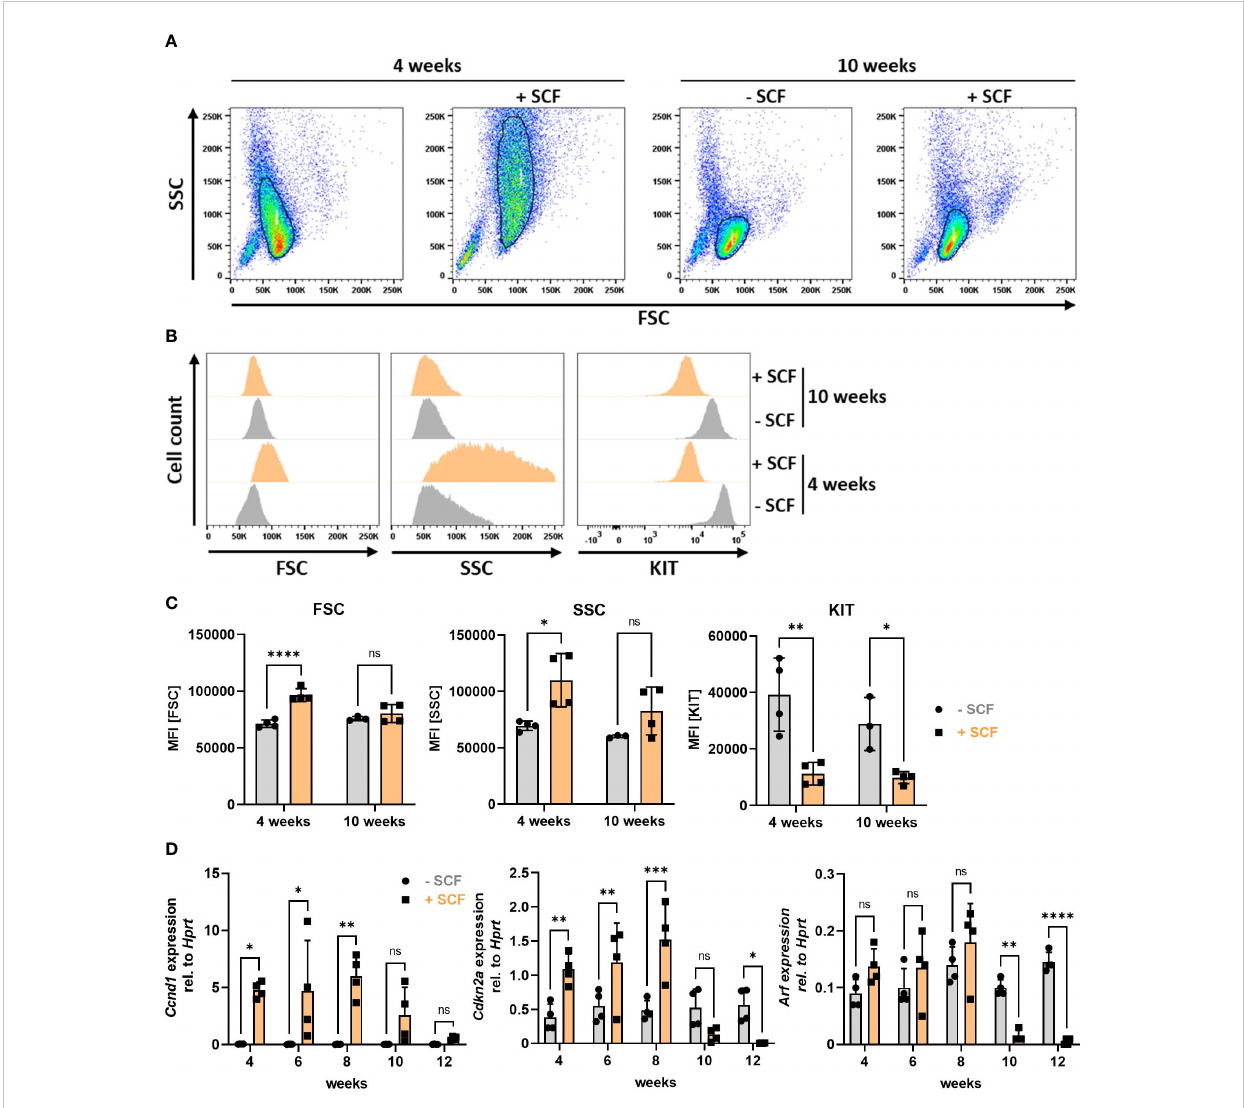
FIGURE 8 Constitutive KIT activation induces morphological changes and loss of Cdkn2a/Arf expression in BMMCs. (A) Representative FACS-plots showing BMMC populations cultivated with or without SCF for 4 (left) or 10 (right) weeks (n=4). (B) Representative histograms showing frequency distributions offorward scatter (left), side scatter (middle) and KIT expression (right) of BMMCs cultivated for 4 or 10 weeks with or without SCF (n=4). (C) Quanti fi ed data (MFI) of parameters analyzed in (B) [n=4 for all data except for BMMCs -SCF at 10 weeks (n=3)]. (D) RT-qPCR analysis of Ccnd1 , Cdkn2a and Arf mRNA expression in BMMCs supplemented or not with SCF over a period of 12 weeks (n=4). Symbols indicate biological replicates. (C) and (D) Ordinary two- way ANOVA followed by S ı ́ da ́ k multiple comparisons test. p >0.05 ns, * p <0.05, ** p <0.01, *** p <0.001, **** p